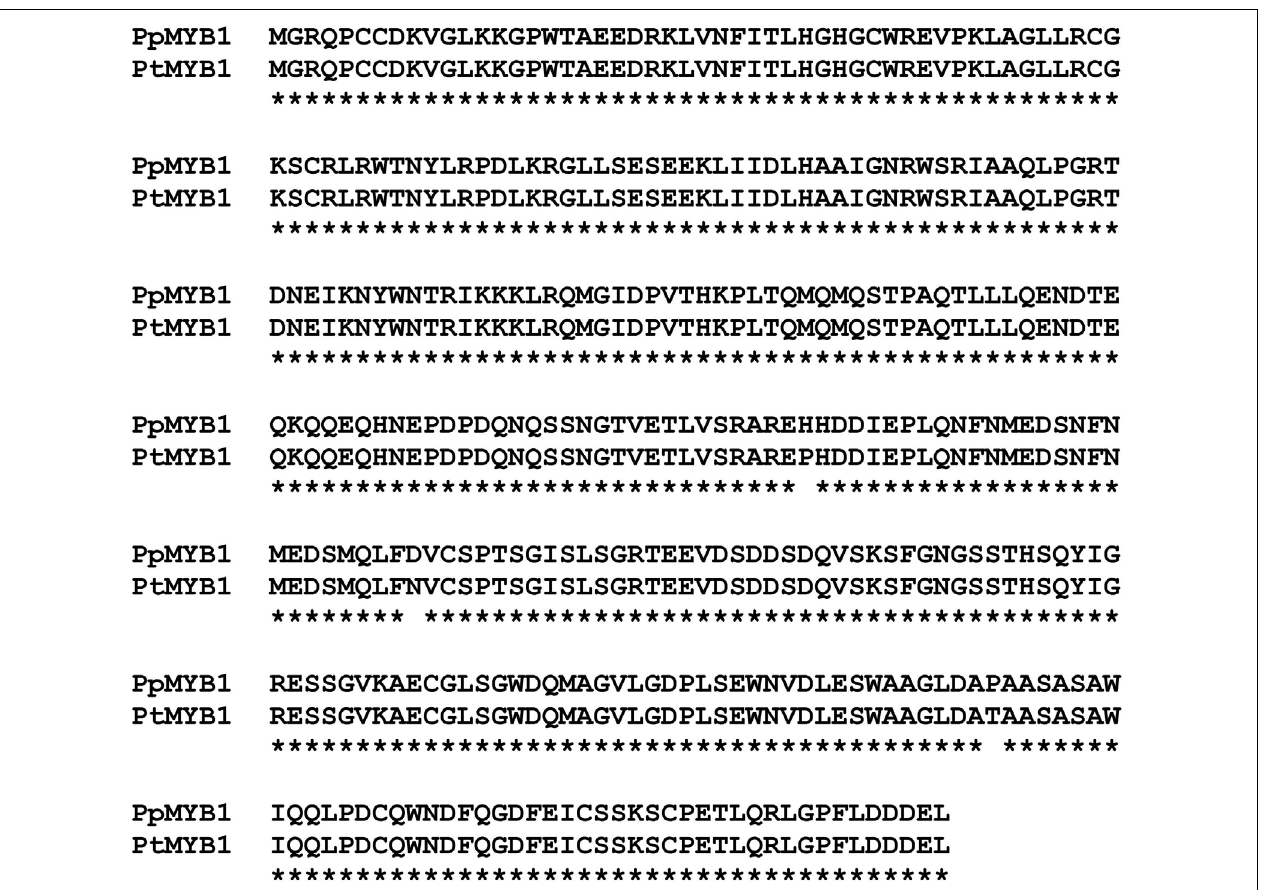
FIGUREA2 |Alignment of the deduced amino acid sequences of PtMYB1 and PpMYB1 full-length cDNAs. PtMYB1 (AY356372); PpMYB1 (EU487890). Identical residues are marked with an asterisk.